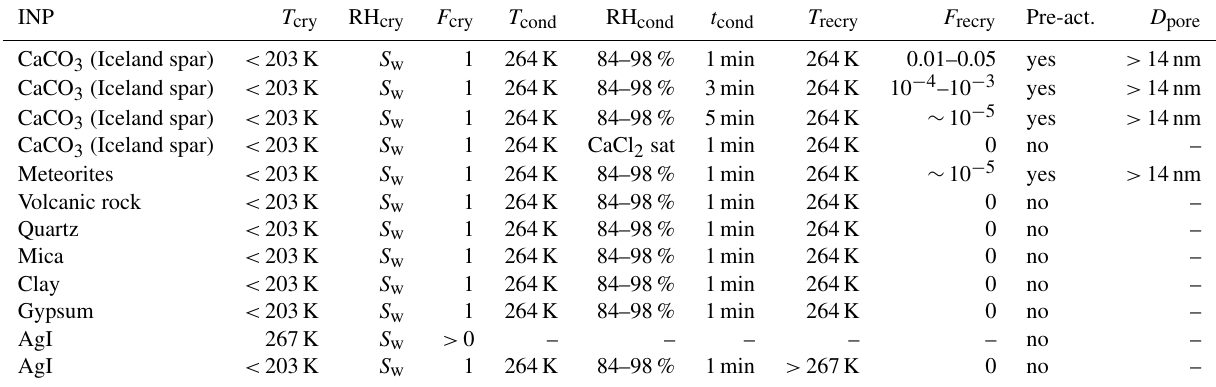
Table 3. Freezing chamber experiments by Day (1958). T cry – first crystallization temperature; RH cry – first crystallization RH; F cry – crystallized fraction of cloud droplets; T cond – conditioning temperature; RH cond – conditioning RH with respect to ice; t cond – conditioning time; T recry – recrystallization temperature; F recry – recrystallized fraction of cloud droplets; D pore – pore diameter needed to prevent ice from melting; S w – water